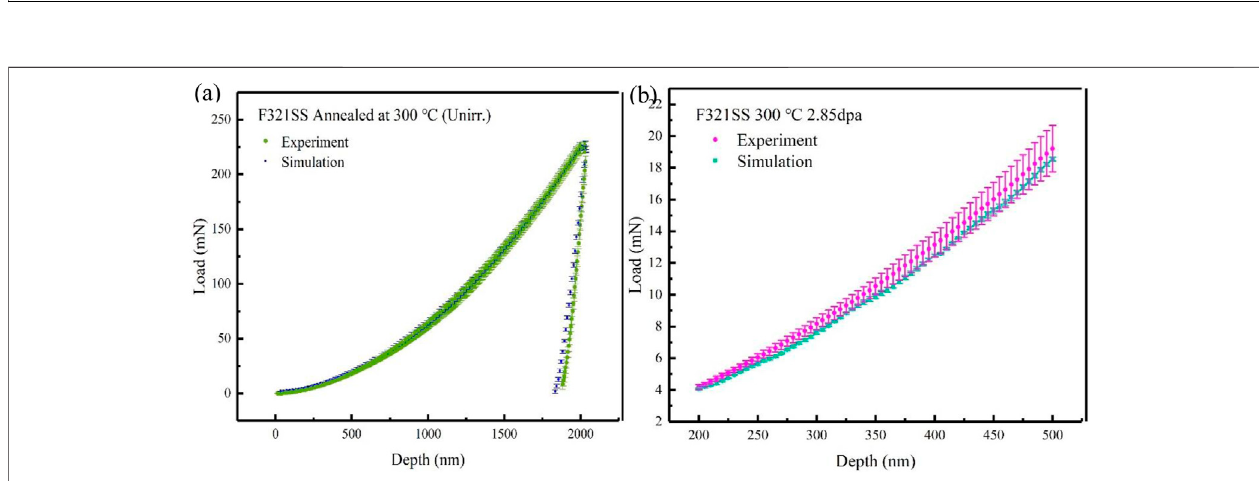
FIGURE12| Comparisonoftheexperimentandsimulationfortheloadtrendwithadepthof (A) unirradiatedF321austeniticstainless-steel,and (B) irradiatedF321 austenitic stainless-steel with a 2.85 dpa dose at 300 ° C.